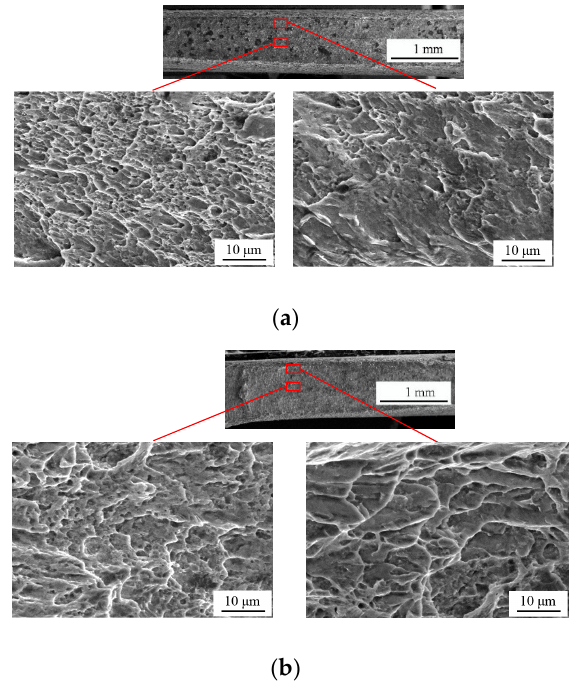
Figure 9. Fracture morphology of shear-dominated specimens: ( a ) S-30 and ( b ) S-45.